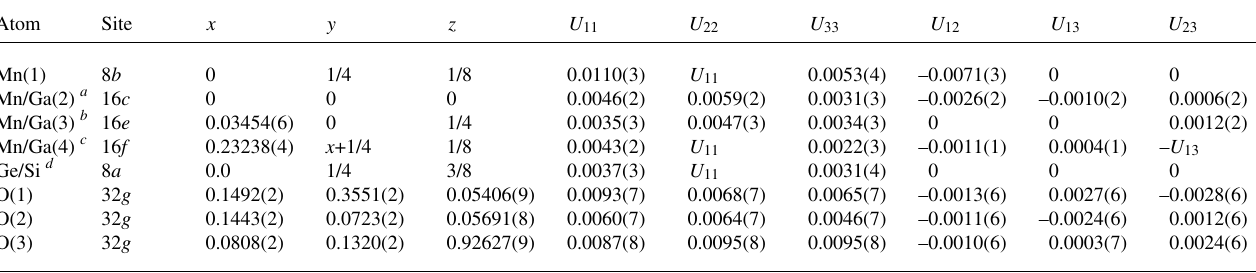
Table 6. Atomic coordinates and displacement parameters (in Å 2 )